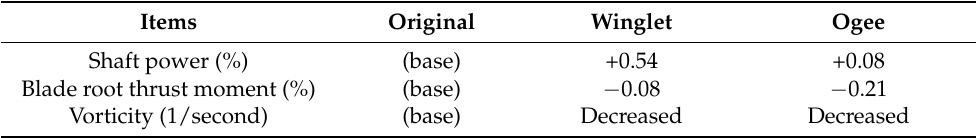
Figure 13. Three-dimensional vorticity distribution according to various rotor blade tip. ( a ) Original tip design (base), ( b ) optimized winglet tip design, ( c ) optimized ogee tip design. Table 3. Comparison of aerodynamic characteristics.